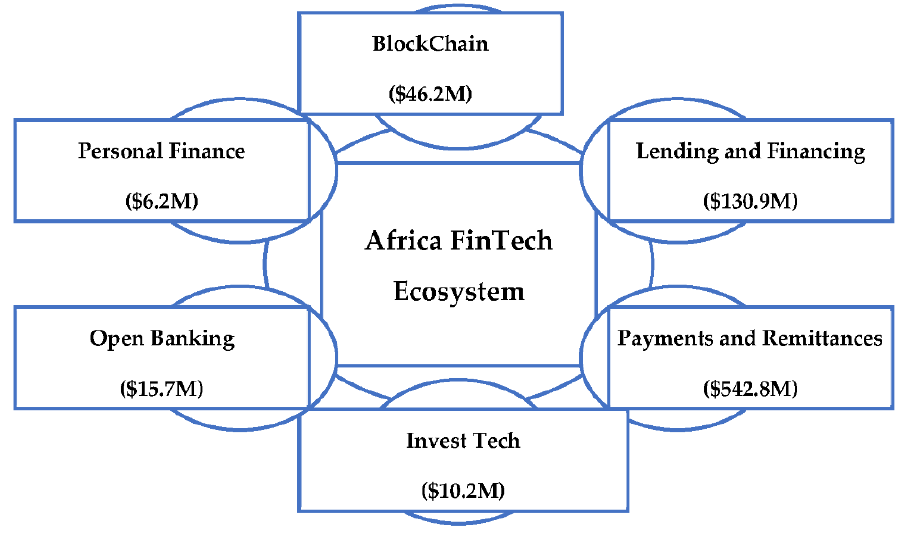
Figure 5. Digital finance ecosystem in Africa. Source: see [29].